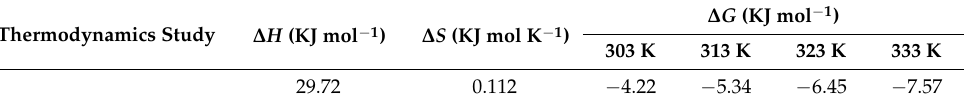
Figure 9. The slope and intercept of Figure 9 computed the enthalpy and entropy of the reaction, which are given as ∆ H 0 = 29.72 KJ mol − 1 and ∆ S 0 = 0.112 KJ mol − 1 K − 1 . The Gibbs free energy ∆ G 0 was calculated using Equation (16), and is given as − 4.22 KJ mol − 1 at 303 K, − 5.34 KJ mol − 1 at 313 K, − 6.45 KJ mol − 1 at 323 K, and − 7.57 KJ mol − 1 at 333 K, respectively. The negative values of ∆ G 0 indicate that the interaction of Pb (II) and XGFO is spontaneous and feasible. The feasibility of the reaction increases with increase in